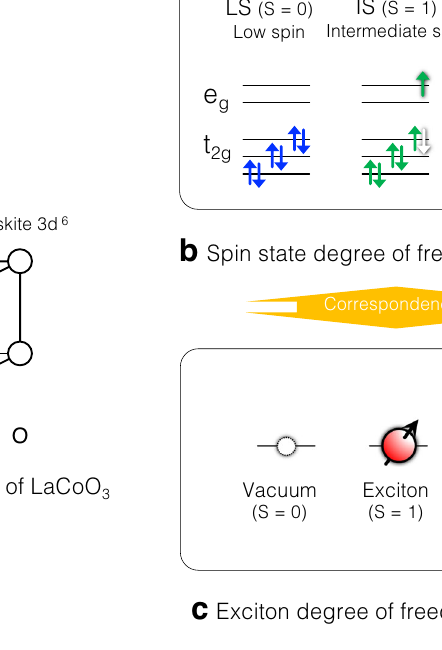
Fig. 1 | Schematic illustrations describing the correspondence between spin- states and exciton states in LaCoO 3 . a Schematic crystal structure of LaCoO 3 . b Schematic drawing of spin-state degrees of freedom of LaCoO 3 . c Schematic